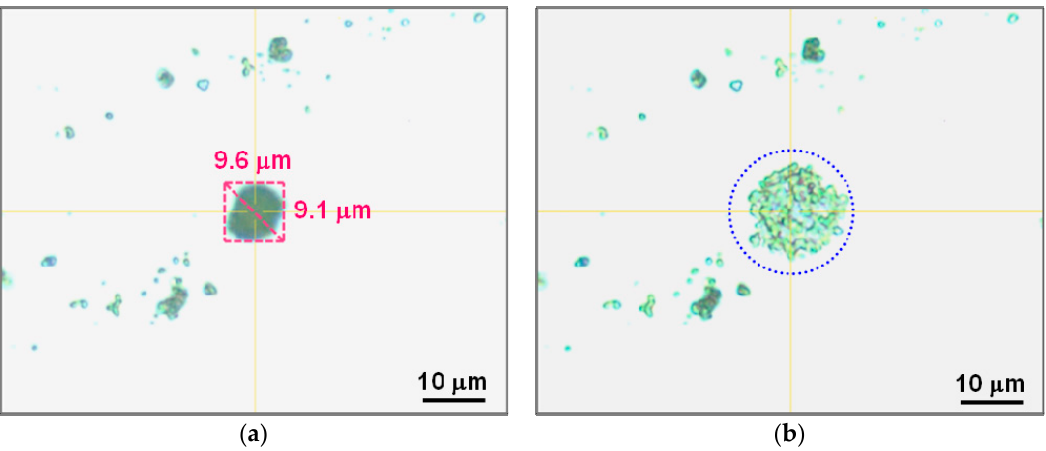
Figure 6. Optical micrographs of an agglomerate of the lightly fatty acid-coated sample ( a ) before and ( b ) after the nano-indentation test.